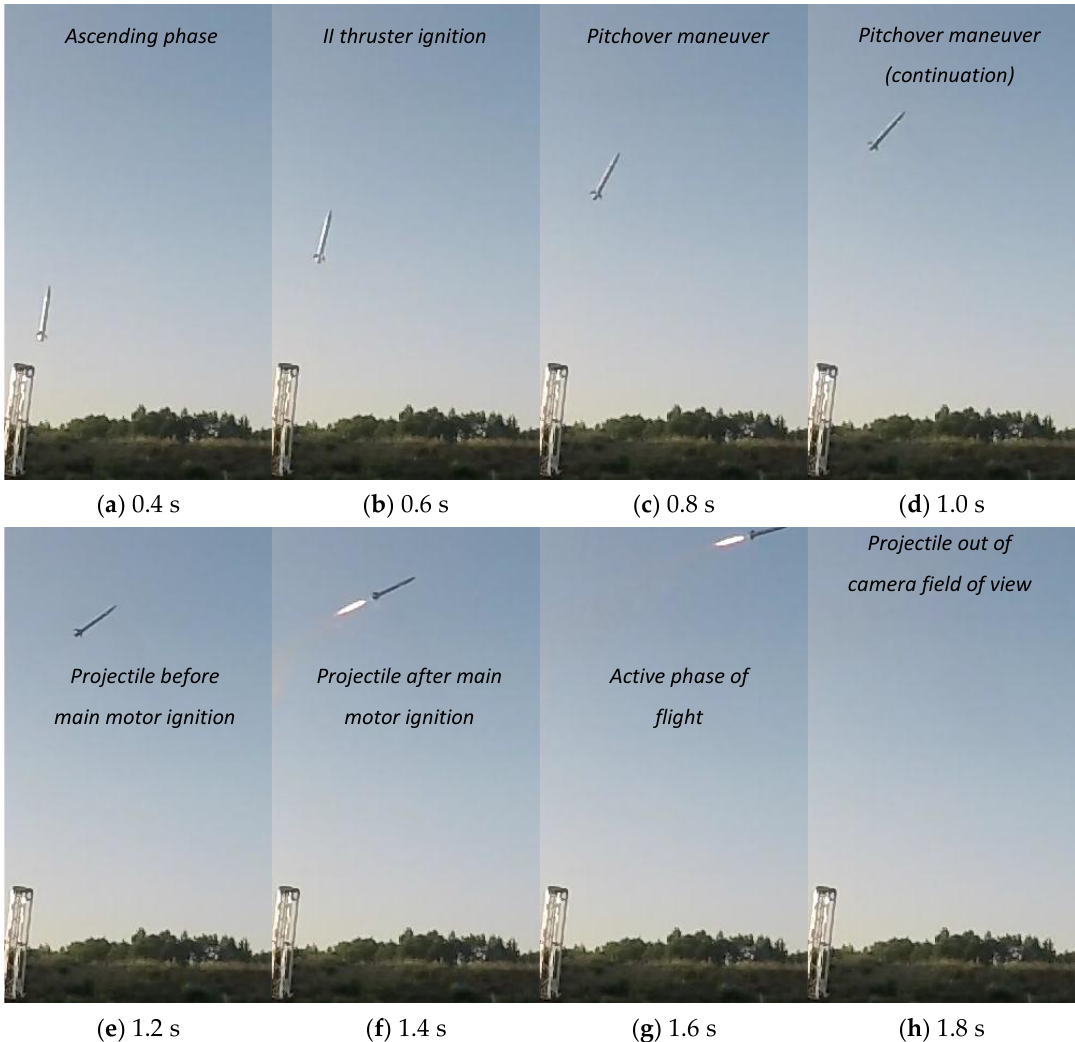
Figure 21. The launch phase of the missile (test 3, lateral thrusters before the center of mass).